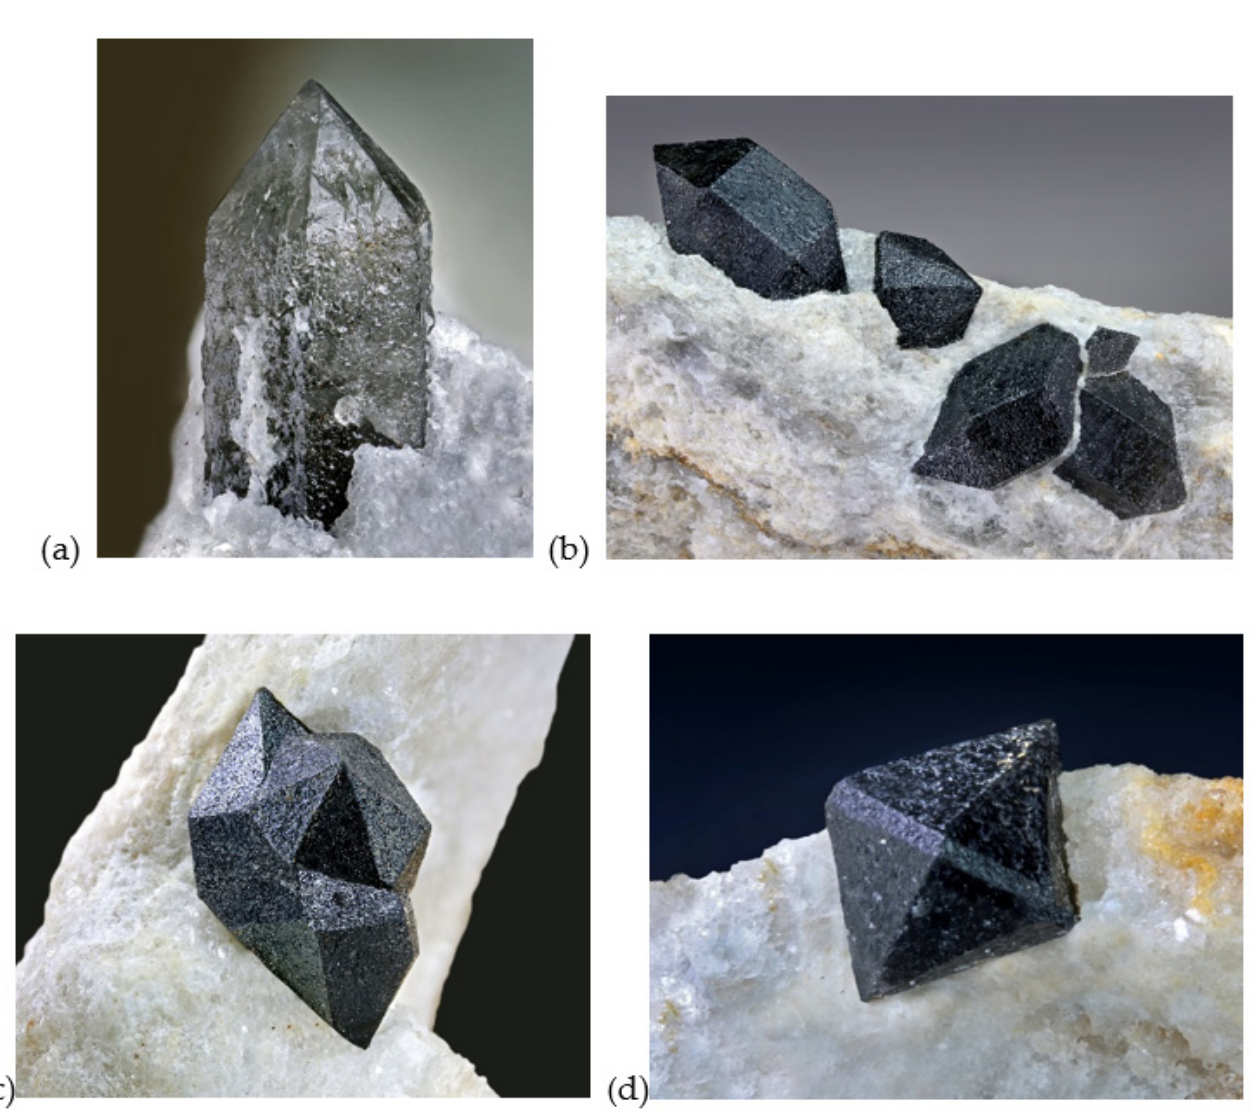
Figure 7. Quartz crystals of the Val Secchia (Monte Rosso) gypsum rock formation: ( a ) grey: length 15 mm; ( b ) black: length of the crystal on the left 30 mm; ( c ) black: length 32 mm; ( d ) black: length 30 mm. Note the rough surface due to the imprints of the white anhydrite crystals. Photos by Antonio Miglioli.